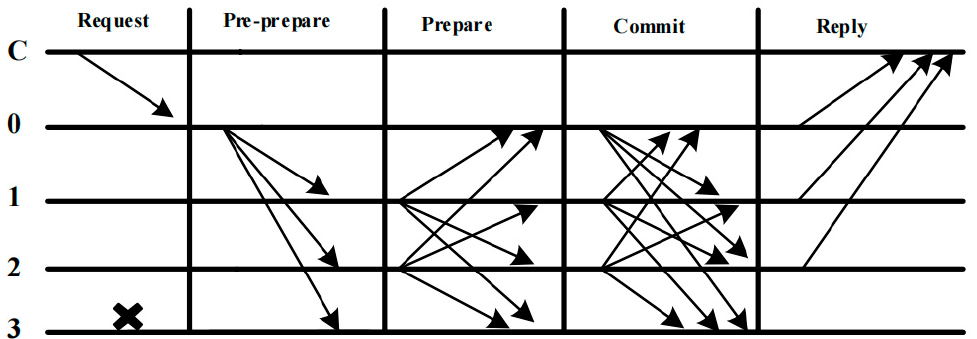
Figure 3. Flow chart of the PBFT consensus mechanism.